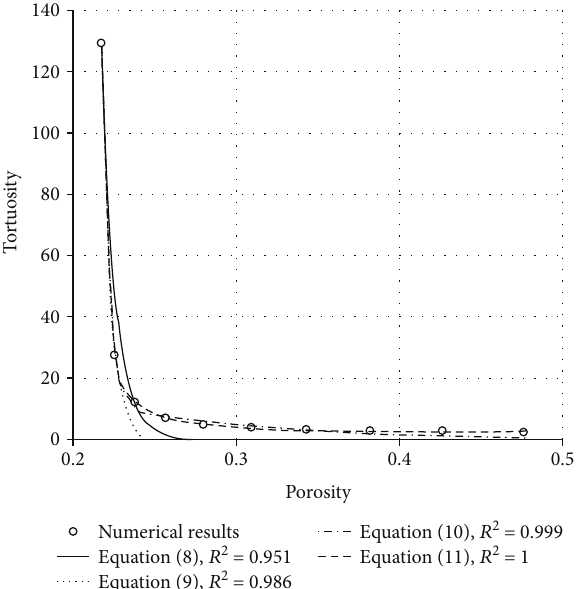
Figure 16: Comparison of numerical results and equations (8), (9), (10), and